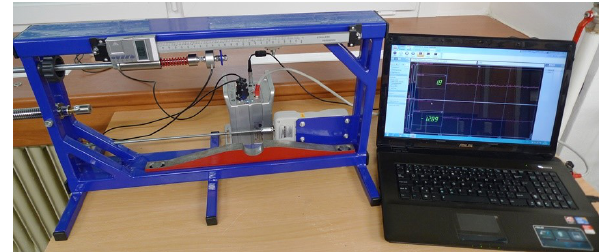
Figure 9: Testing equipment for the calibration of force transducers